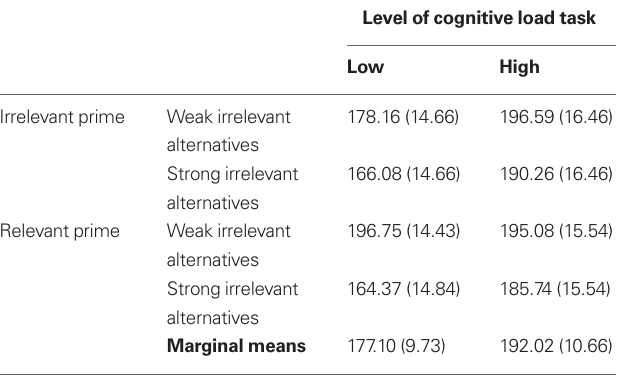
Table 4 | Mean judgment sums as a function of cognitive-load level, relevancy of prime, and strength of irrelevant alternatives for experiment 2.